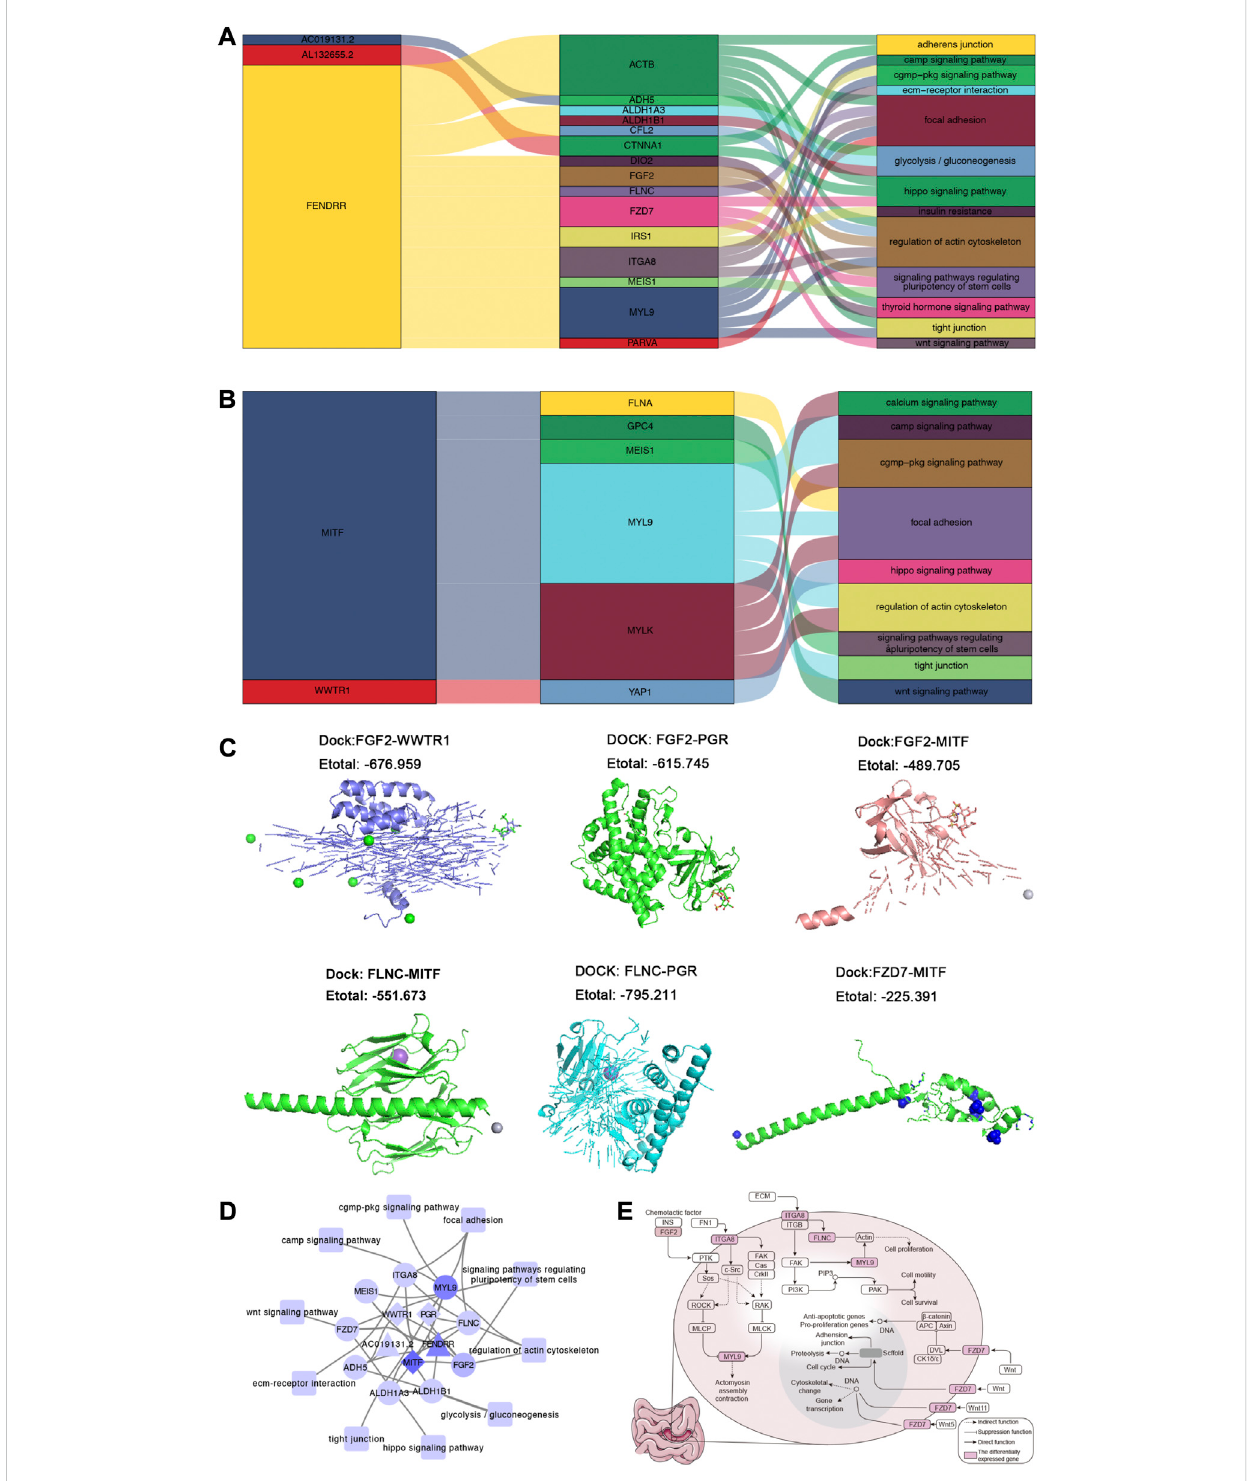
FIGURE 4 The global regulatory landscape in SI-NETs. (A) Sankey plot: Graphical summary of lncRNA regulating KEGG pathways through mRNA. (B) Sankey plot: Graphical summary of TFs regulating KEGG pathways through mRNA. (C) Molecular docking model: The prediction of targeted binding FGF2 and WWTR1/PGR/MITF, FLNC and MITF/PGR, as well as FZD7 and MITF. (D) The global regulatory landscape SI-NETs: lncRNA/TFs-mRNA-KEGG pathways network. (E) 3 KEGG pathways for further study. Node maps degree value. Light purple represents a smaller degree value, while dark purple representing a larger degree value. Degree value represents the number of genes interacting with other genes. SI-NETs, small intestine neuroendocrine tumors; KEGG, Kyoto Encyclopedia of Genes and Genomes; TFs, transcription